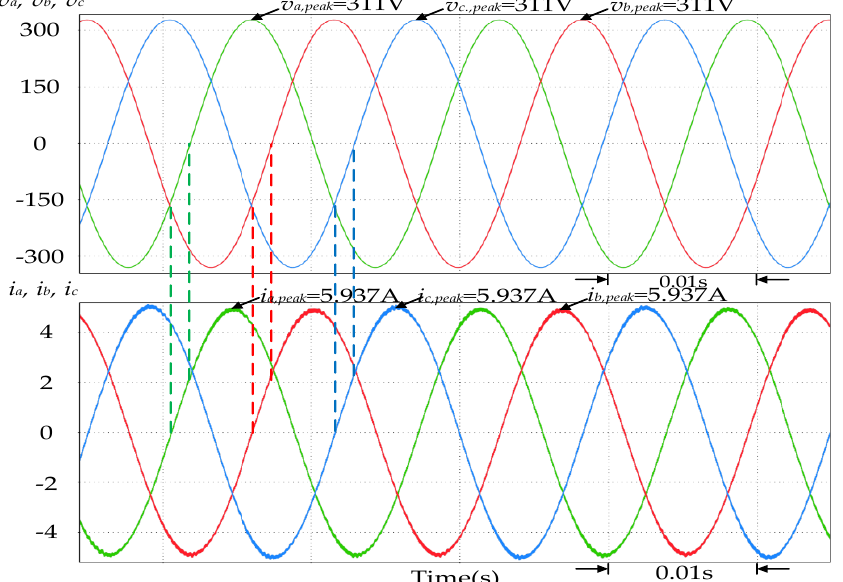
Figure 14. The three-phase output voltage and current waveforms of the smart inverter when the per-unit value of mains voltage was between 1p.u. and 1.03p.u.